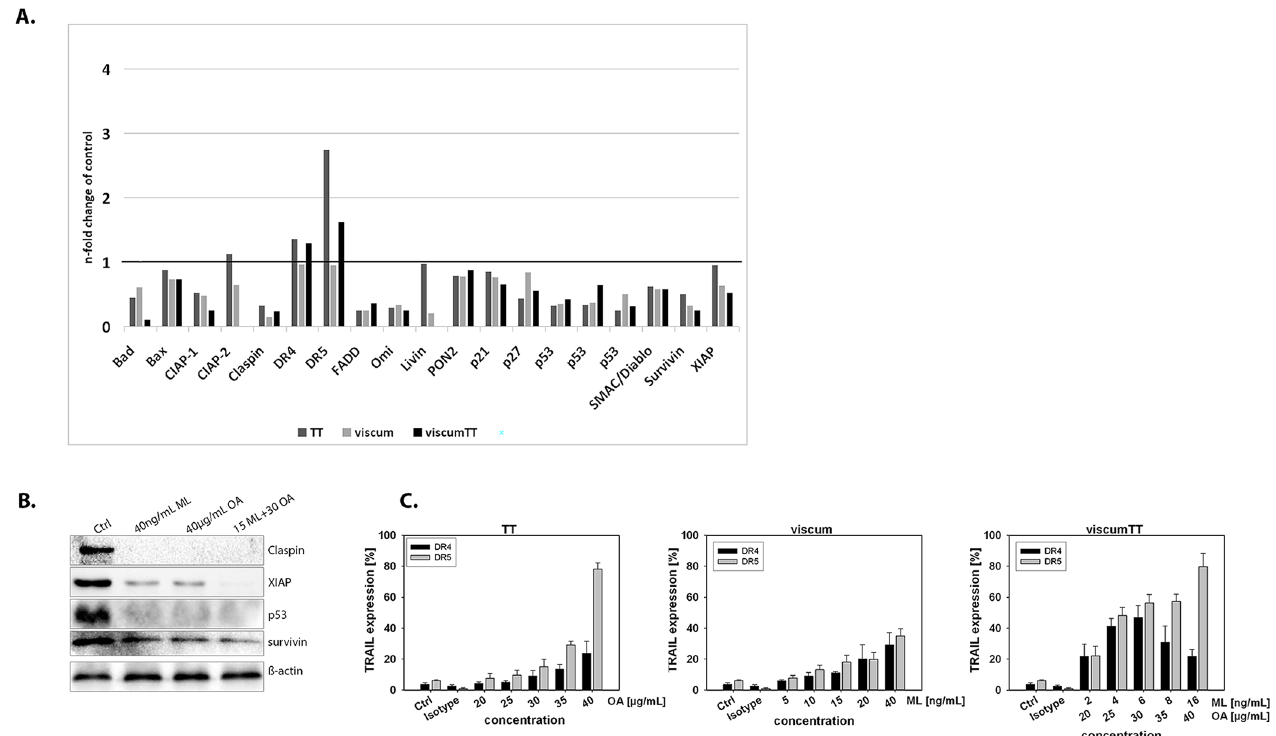
Fig 4. Expression of apoptosis associated proteins in HL-60 cells after VAE treatment. A. HL-60 cells were treated with depicted VAE concentrations (~IC50) for 18 h. Cell lysates were incubated with a human apoptosis array detecting the relative expression of apoptosis-related proteins per sample. Each experiment was carried out in duplicate (n = 2). VAE treatment changes the expression of apoptosis associated proteins resulting in an increase of TRAIL-R1 and a decrease in several proteins including XIAP, survivin, claspin and p53. B. The down-regulation of survivin, XIAP, p53 and claspin was confirmed by Western blot. C. Activity of TRAIL-receptor-1 and -2 was measured by FITC-labelled monoclonal antibody and flow cytometry after treatment of HL-60 cells with distinct VAE concentrations for 18 h.